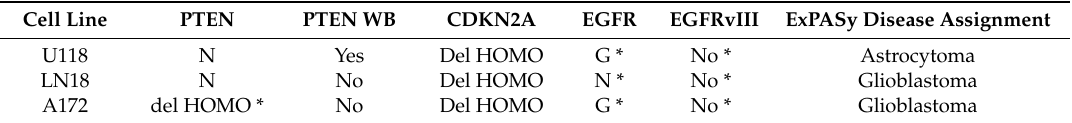
Table 1. Molecular classification of glioblastoma (GBM) cell lines according to several significant GBM markers. Obtained from [20,21] and